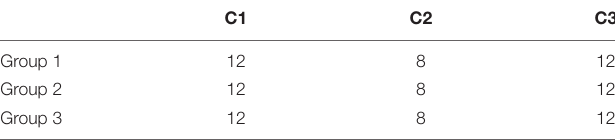
TABLE 1 | Composition of the three groups of samples.